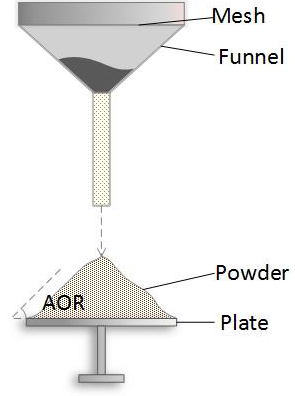
Figure 2. Schematic diagram of AOR measurement.